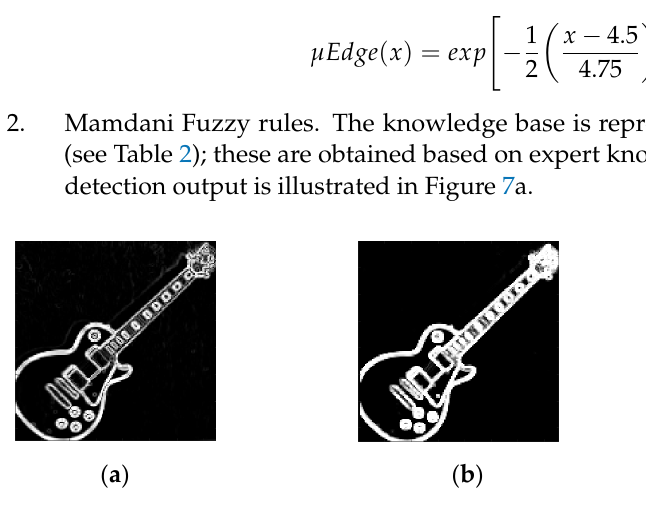
Figure 7. ( a ) Fuzzy Sobel edge-detection output. ( b ) Fuzzy MG output. Algorithm 1 summarizes the process for calculating Prewitt and Sobel fuzzy edge-detection. Algorithm 1. Fuzzy edge-detection using Prewitt and Sobel operators.